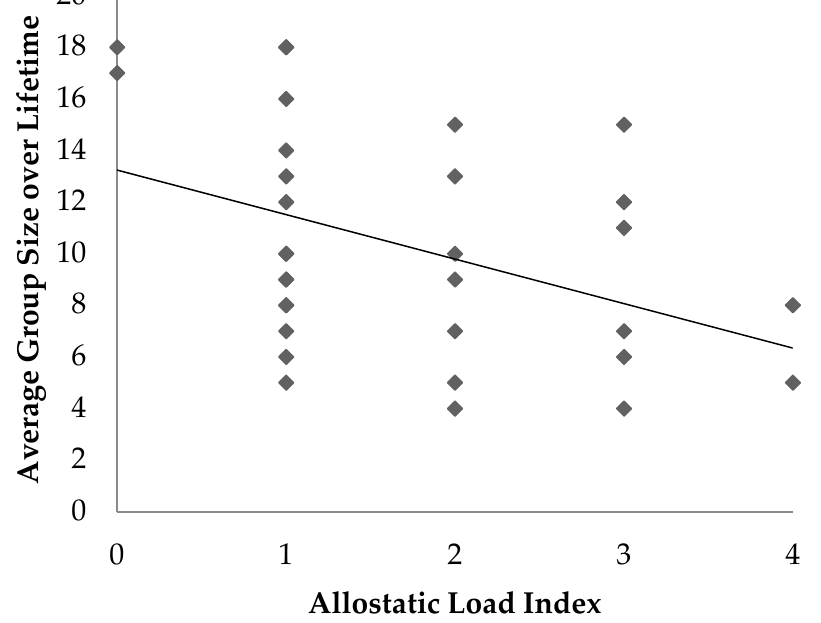
Figure 2. Scatter plot illustrating the association between allostatic load index and the total number of group composition changes experienced by ( a ) female ( n = 22) and ( b ) male ( n = 16) ring-tailed lemurs ( Lemur catta ).